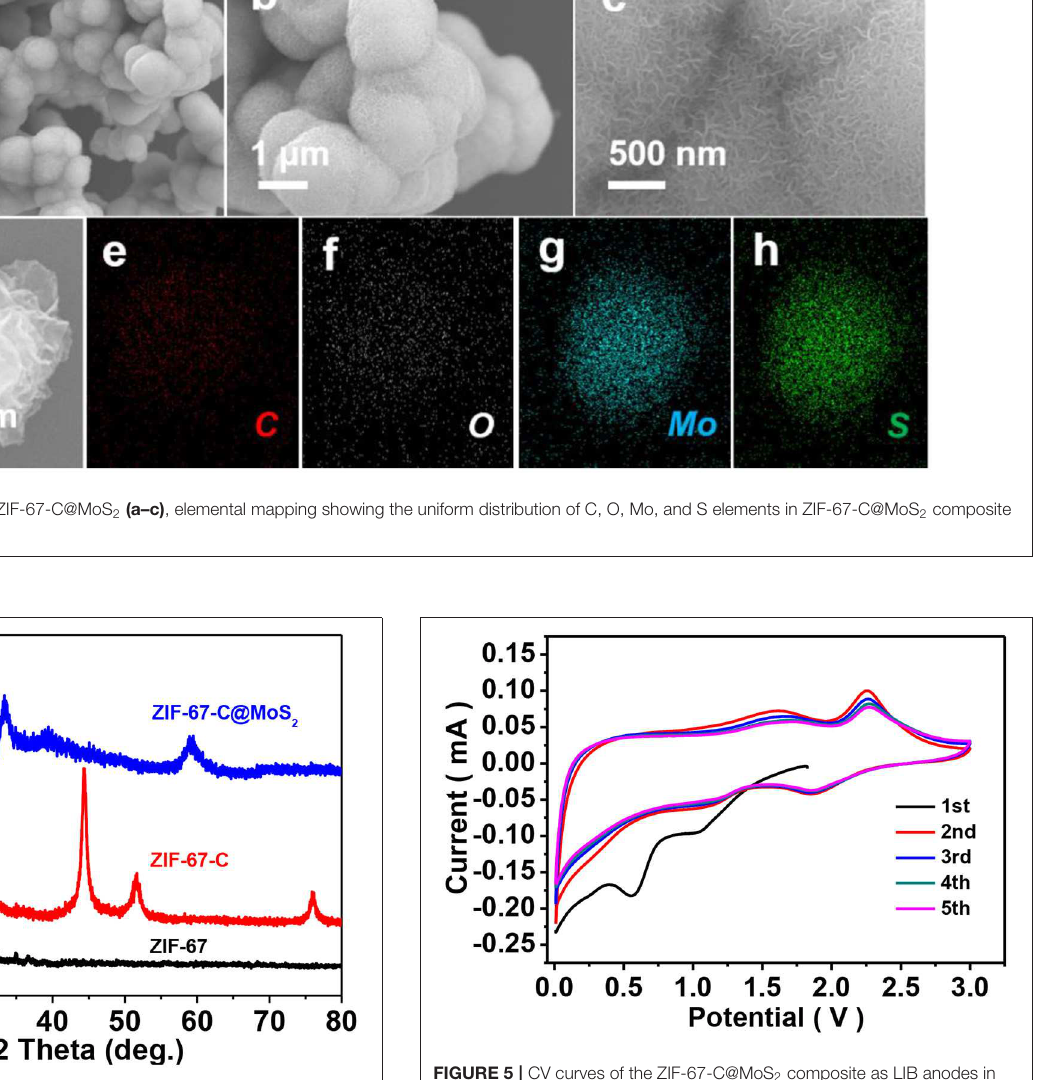
rough and many carbon nanotubes covered can be observed.